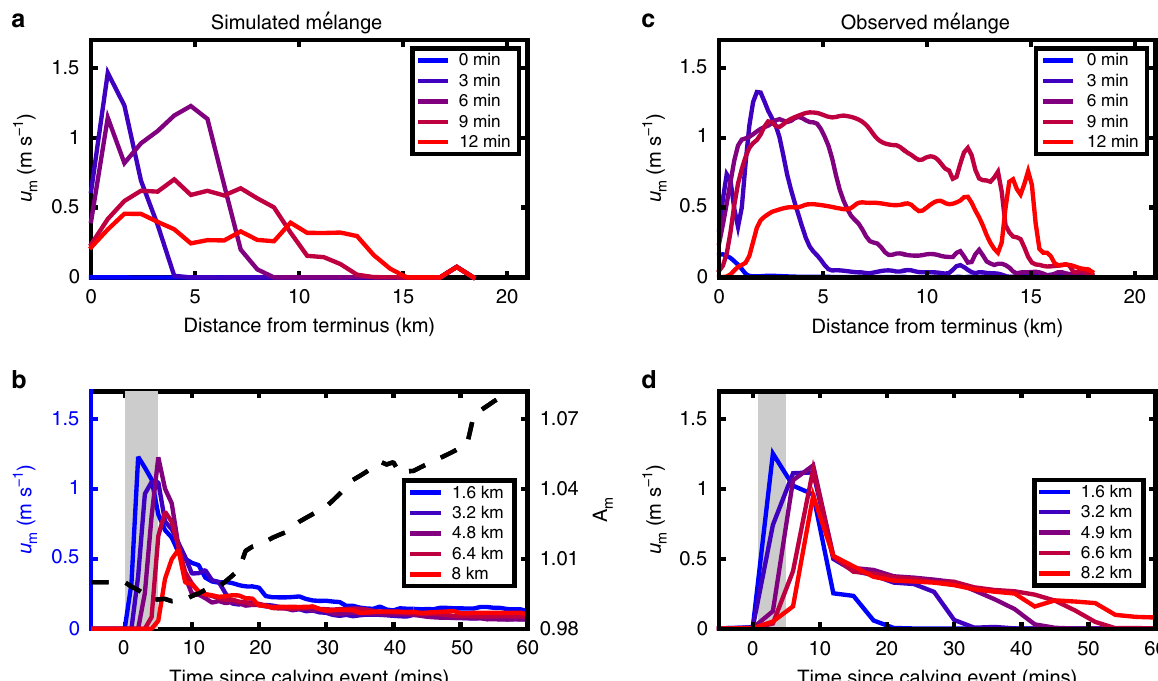
Figure 3 | Spatiotemporal response of me´lange without sea ice to a prescribed calving event. ( a , b ) are simulations, and ( c , d ) are observations from Jakobshavn Isbræ reproduced from Fig. 3 in Peters et al. 24 . ( a , c ) Me´lange velocity (averaged across channel width) as a function of distance along channel length at different times following calving event. ( b , d ) Me´lange velocity (averaged across channel width) as a function of time following calving event at different locations along channel length. Grey shading indicates duration of calving event. Black dashed line plots the area occupied by me´lange normalized by pre-calving area.